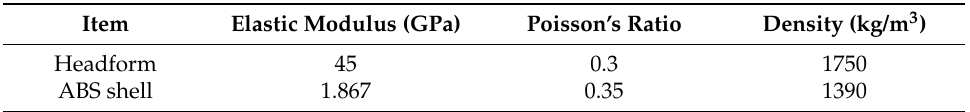
Figure 4. Experimental stress vs. strain curves for Expanded Poly-Polystyrene (EPS) foam (reproduced with permission from [15], Elsevier, 2003). Table 2. Finite element model details *.